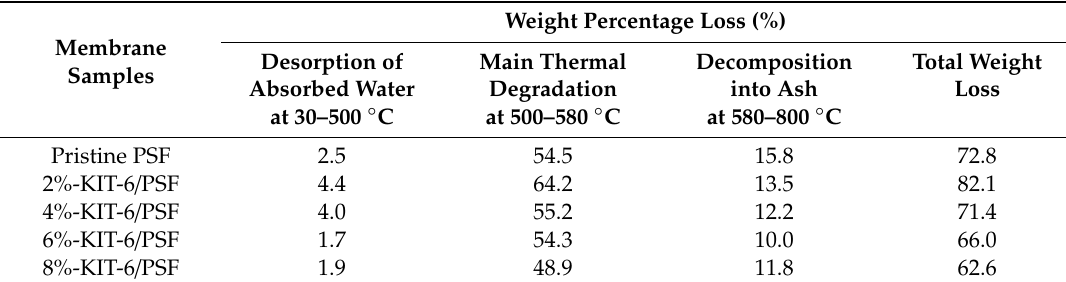
Table 1. Weight loss percentage of membranes via TGA analysis [15,25,26].